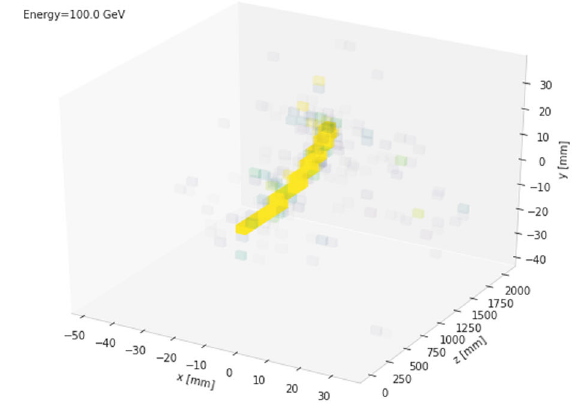
Fig. 2 Pairofexamplesofmuonsenteringthesimulatedcalorimeterin the z direction. The colour palette indicates the energy of each deposit, relative to the highest-energy deposit for each muon, moving from blue, through green, to yellow in increasing energy